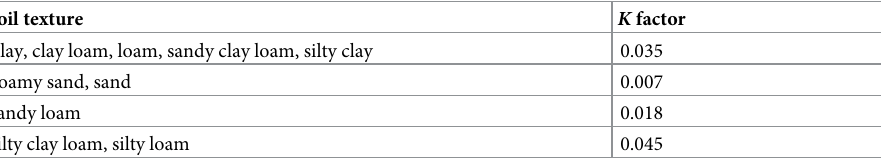
Table 2. K values for different soil textural classes in the study